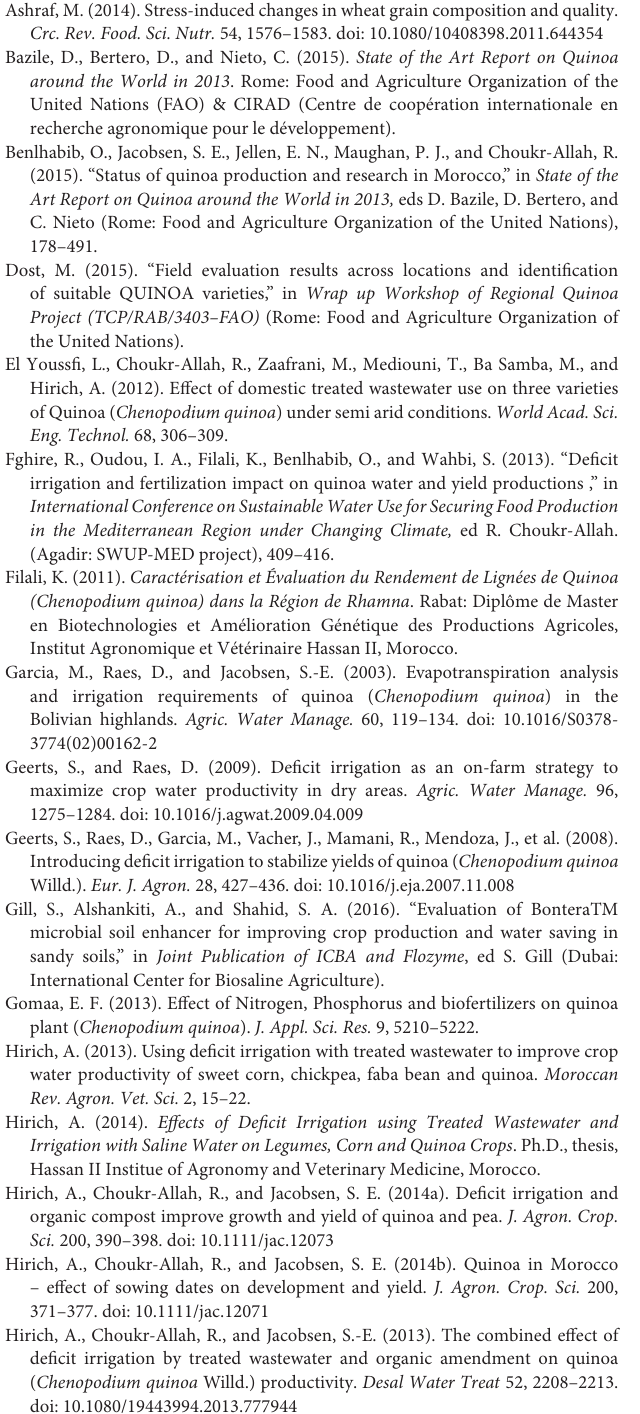
Supplementary Figure 3 | Sowing date trial carried out in Agadir, Morocco. Supplementary Figure 4 | Quinoa harvest within field trial on combined impacts of water stress and nitrogen application carried out in Agadir, Morocco.